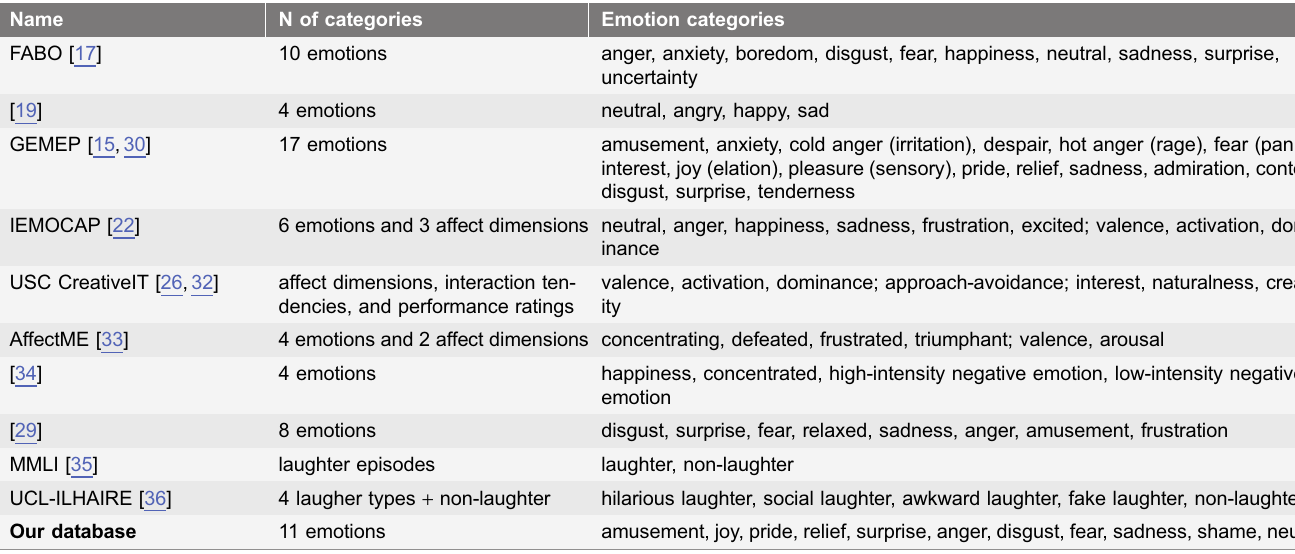
Table 2. Emotion categories used in the databases included in Table